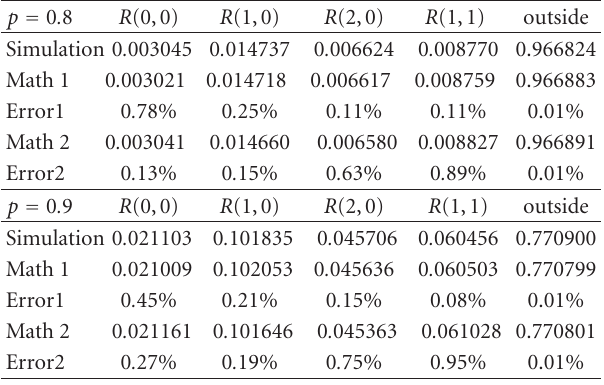
Table 2: Paging and Idle Mode Related Signaling